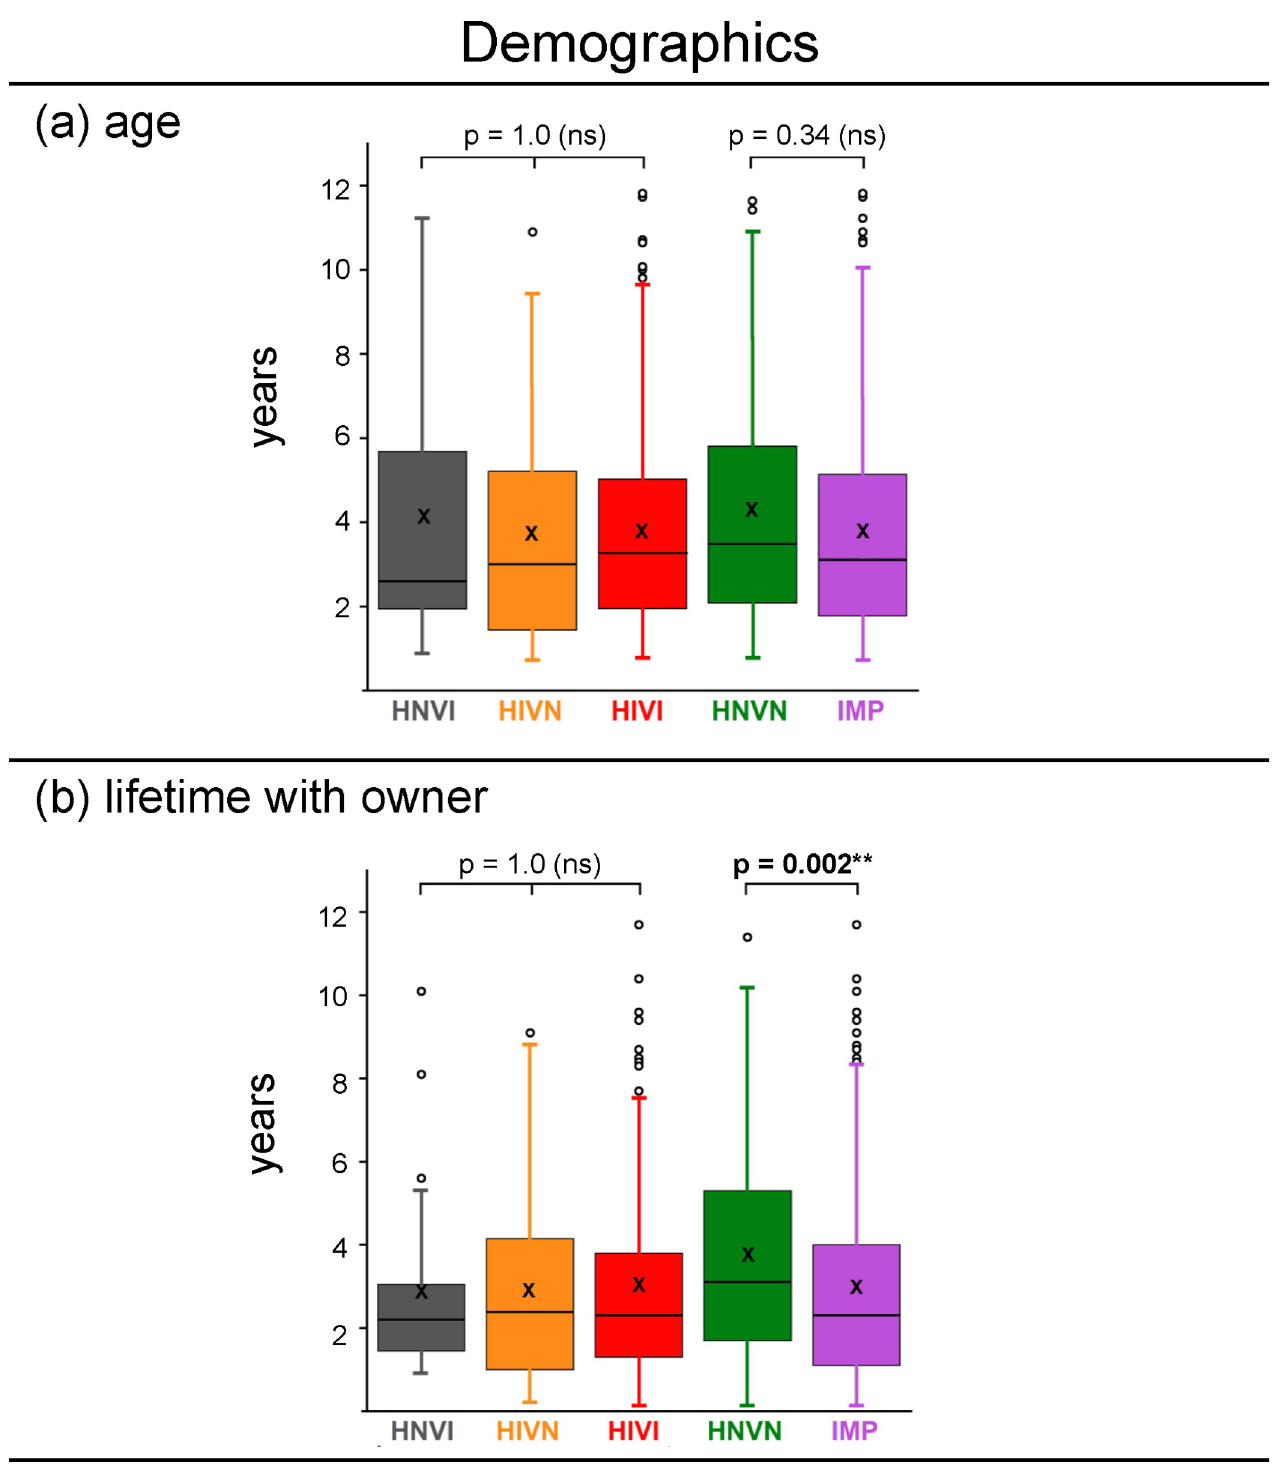
Fig 1. Box-plots of individual values of (a) age and (b) lifetime with owner for each group, and for the three sensory impaired groups gathered (IMP). HNVI = hearing normal vision impaired (grey), HIVN = hearing impaired vision normal (orange), HIVI = hearing impaired vision impaired (red), HNVN = hearing normal vision normal (green), IMP = impaired (purple), ns = non significant. The bold bar within the boxplot is the median, the cross is the mean, the bottom and top of the box are the lower and upper quartiles, respectively, and the dots are outlier values above the [upper quartile + 1.5 � inter- quartile distance] limit (top of upper vertical bars). Horizontal brackets indicate the two-by-two comparisons between groups that were statistically assessed using Shapiro-Wilk tests. https://doi.org/10.1371/journal.pone.0230651.g001 PLOS ONE | https://doi.org/10.1371/journal.pone.0230651 September 4,